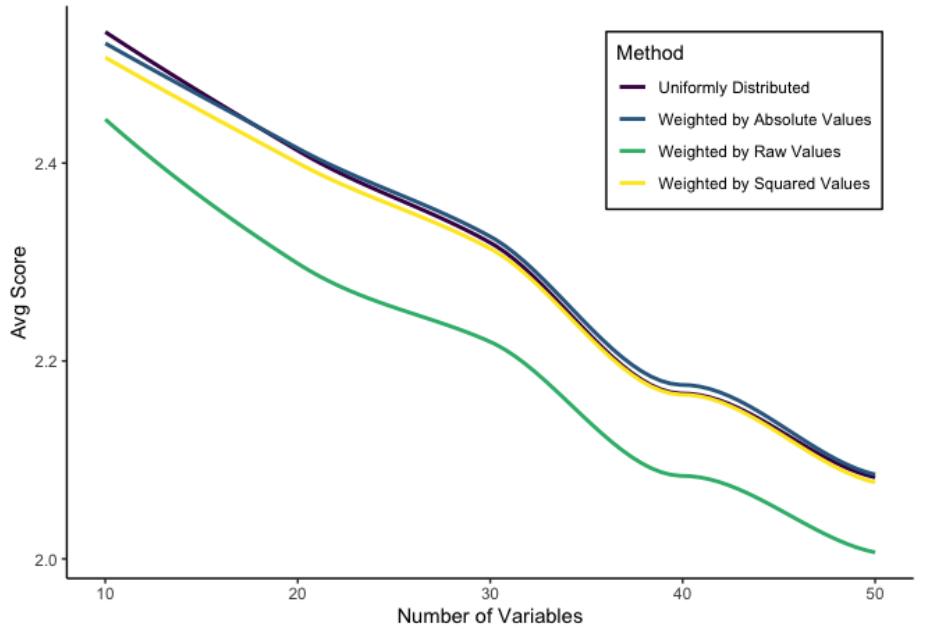
Figure A1. How the number of covariates impacts overall score on average for mSHAP compared to kernelSHAP.